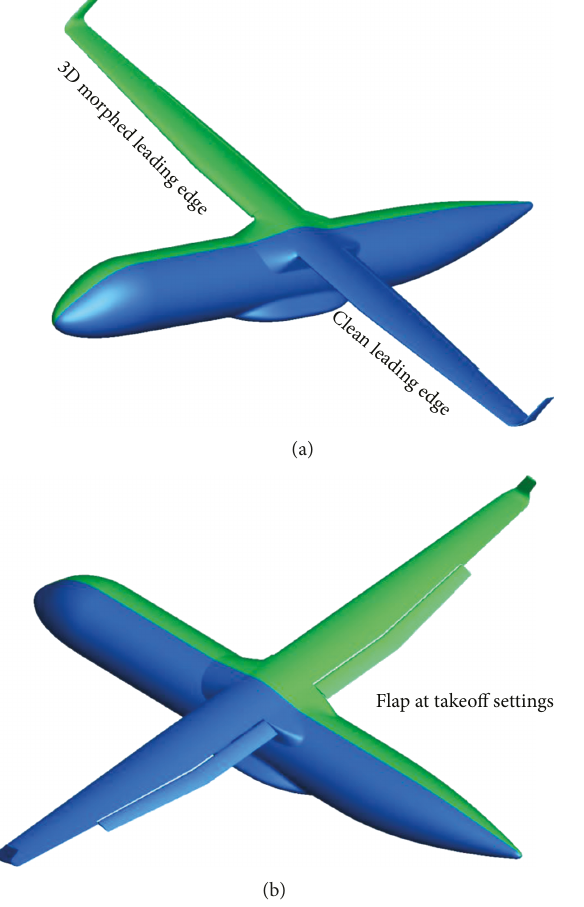
Figure 27: Aircraft con fi gurations considered for the 3D aerodynamic performance assessment. Table 7: Sizes of the di ff erent chimera grids used for 3D CFD performance evaluation.